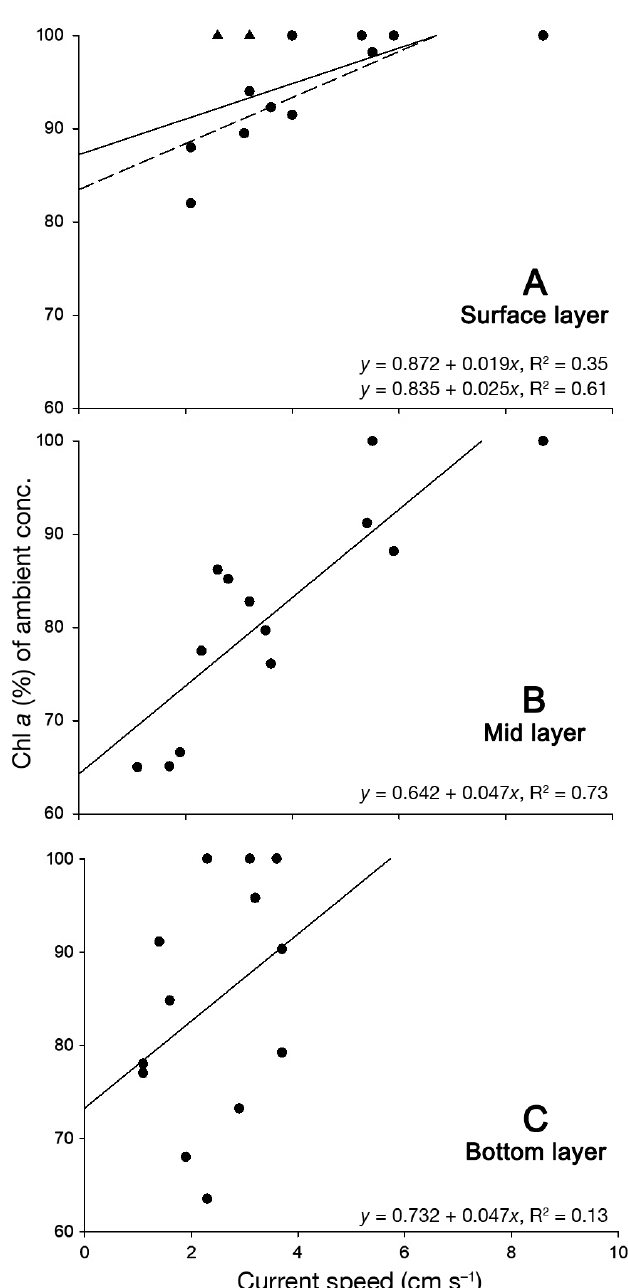
Fig. 6. Measured depletion of chl a as a function of current velocity in 3 depth layers: (A) surface, (B) middle, and (C) bottom. The 2 triangles in (A) are excluded as outliers, as the depth of the top layer (1.3−1.4 m) was above the upper limit of the mussel bands (ca. 1.5 m). Regression lines plotted for all points (solid line) and without outliers in (A) (dashed line)